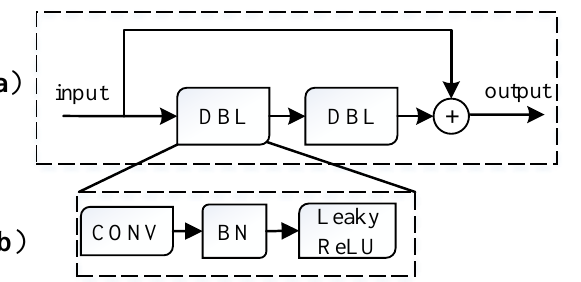
Figure 4. The constituent structural unit of Residual Networks. ( a ) Residual unit. ( b ) DBL unit.